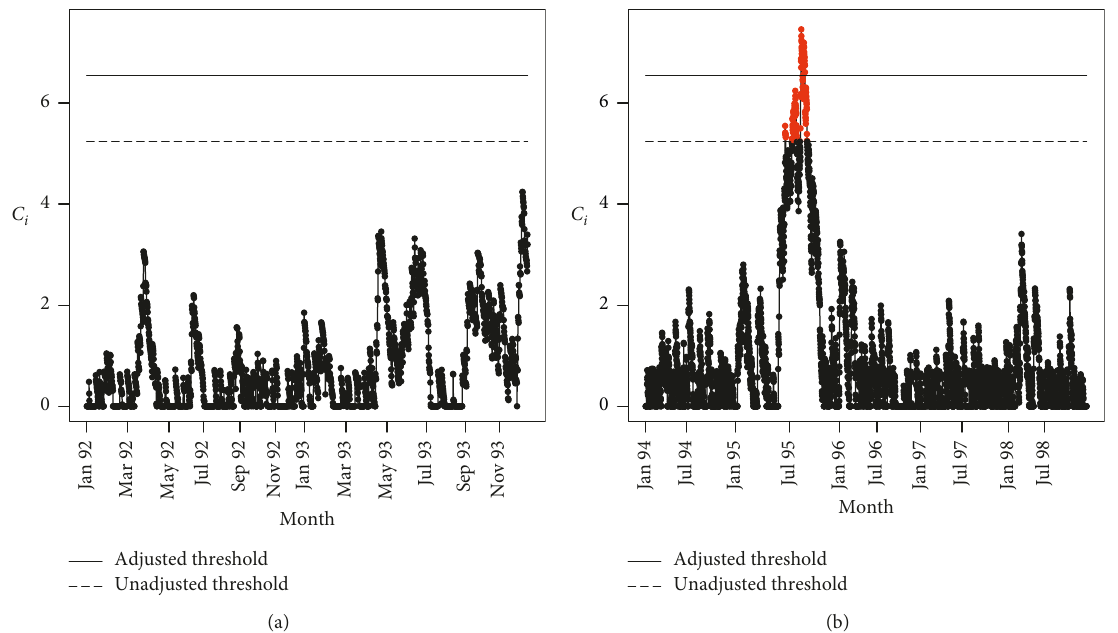
Figure 6: RA-CUSUM chart for Phase-I and Phase-II assuming first two years as the Phase-I for 30 days mortality of cardiac surgery patients. (a) Phase-I chart, unadjusted UCL � 5.238 and adjusted UCL � 6.522. (b) Phase-II chart, unadjusted UCL � 5.238 and adjusted UCL � 6.522.